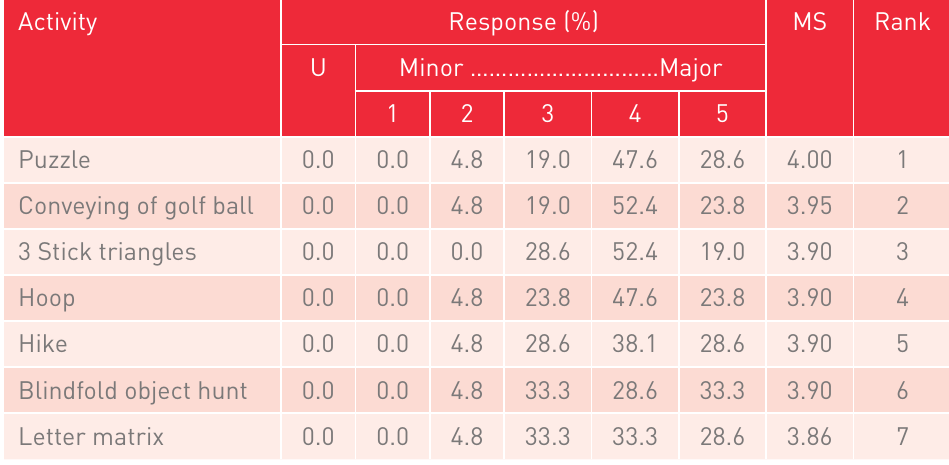
Extent to which the team building activities enhanced participants’ ability to take